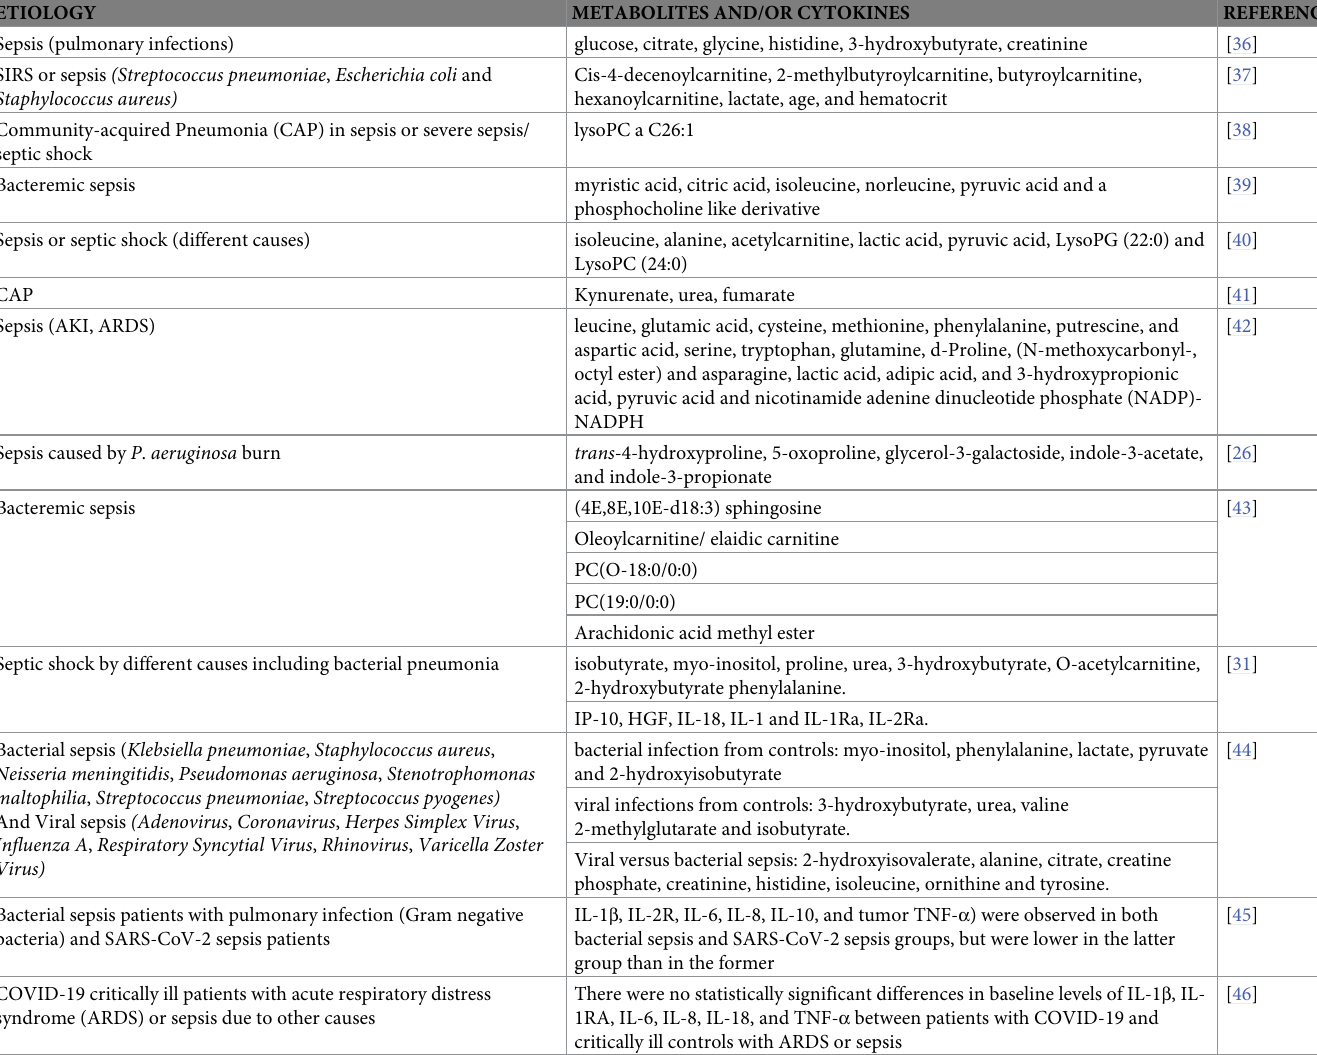
Table 3. Comparison of metabolic and immune mediators in sepsis caused by bacterial, fungal and viral